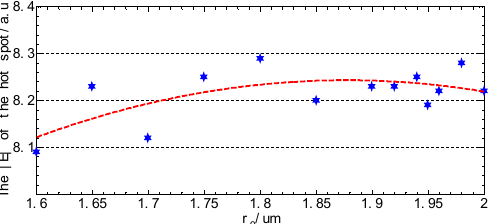
Figure 5. The relation between the electric field |E| of the hot spot and the parameter r 0 when our lens was illuminated by a left-circularly polarized light, w 1 = 310 nm, w 2 = 155 nm, h 1 = 110 nm, h 2 = 45 nm, m = 1, λ = 633 nm, r 0 are set to 1.6 um, 1.65 um, 1.7 um, 1.75 um, 1.8 um, 1.85 um, 1.9 um, 1.92 um, 1.94 um, 1.95 um, 1.96 um, 1.98 um, 2.0 um, respectively.